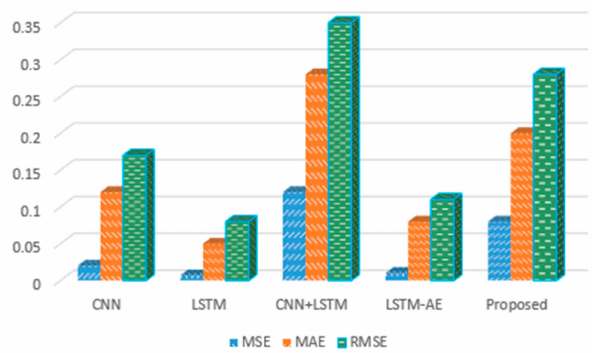
Figure 11. The results achieved by di ff erent deep learning-based models for daily resolution of data on our own